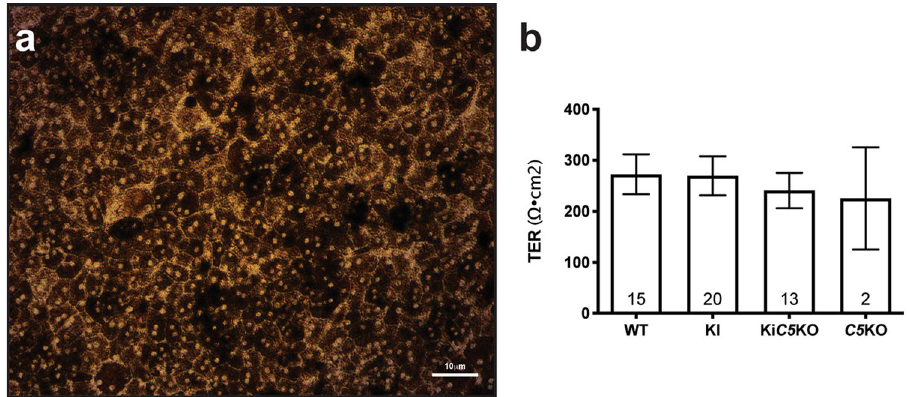
Figure 2. ( a ) Brightfield micrograph of mouse RPE cells Efemp1 R345W/R345W : C5 -/- after two weeks on transwells confirms the formation of a healthy pigmented monolayer with honeycomb morphology. ( b ) Transepithelial electrical resistance (TER) measured after two weeks is similar in all cell cultures regardless the genotype.